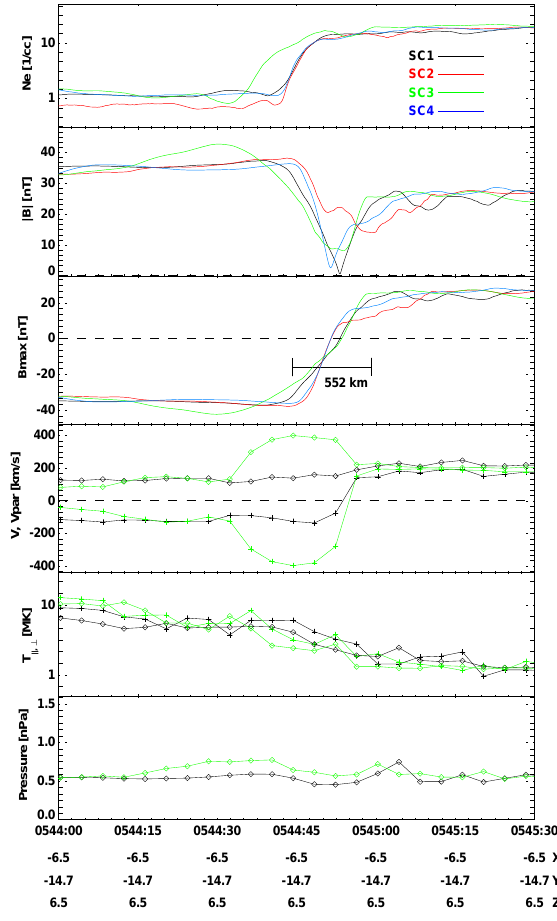
Fig. 7. Plasma and magnetic field data for the inbound magne- topause crossing at 11:01 UT on 5 July 2001. Plot format and la- belling as in Fig. 4. Note the gradual density drop, the field-aligned plasma flow, and the large temperature anisotropy on the magne- topsheric side, which are the characteristics of the plasma